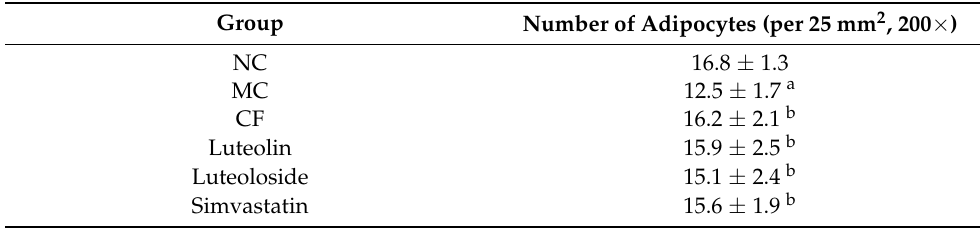
Table 7. Changes in the number of adipocytes in each